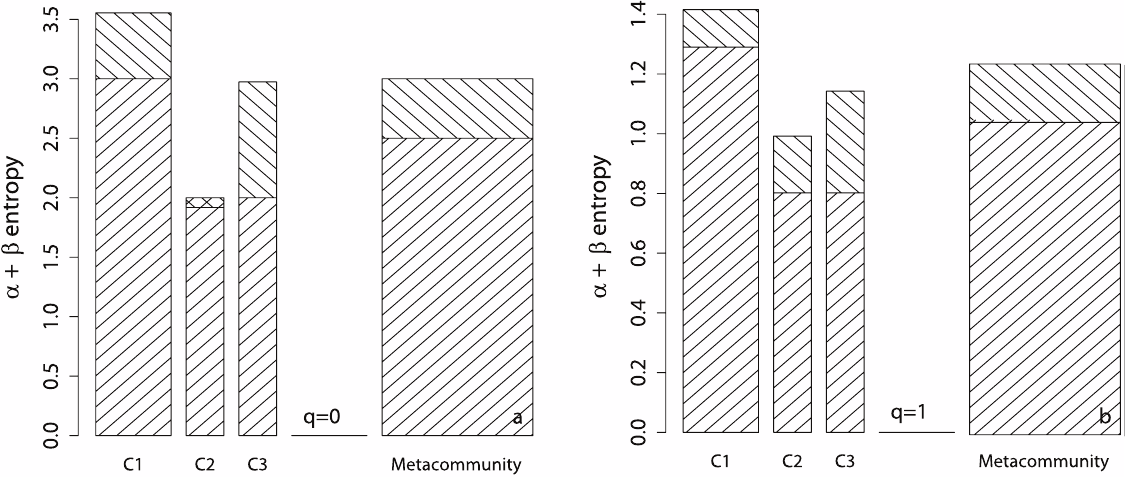
Figure 3. Decomposition of a meta-community entropy. The meta-community is made of three communities named C1, C2 and C3 (described H a (bottom part of the bars) and their contribution to b entropy q H b (top part of the bars) are plotted for q ~ 0 (a) and in the text). Their a entropy q i i q ~ 1 (b). The width of bars is each community’s weight. a and b entropies of the meta-community are the weighted sums of those of communities, so the area of the rectangles representing community entropies sum to the area of the meta-community’s (width equal to 1). c entropy of the meta- community is a plus b entropy.